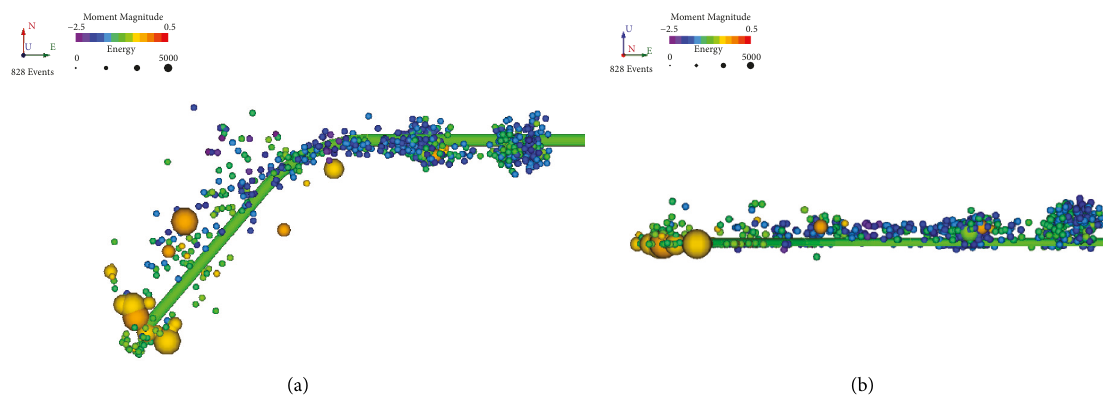
Figure 12: Spatial distribution of microseismic events in the traffic tunnel. (a) Planform. (b) Left view. DensityUN Contouring: Event E 0